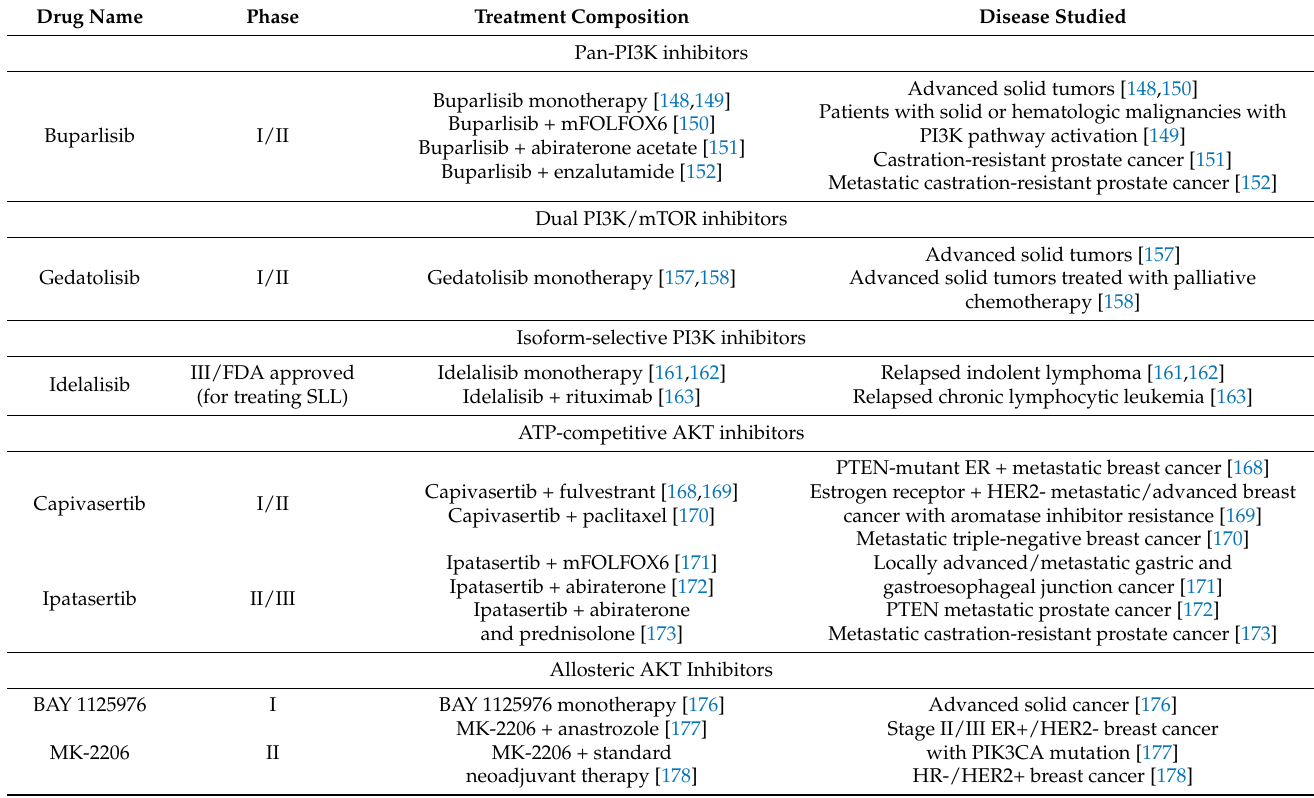
Table 1. PI3K/AKT inhibitors in clinical